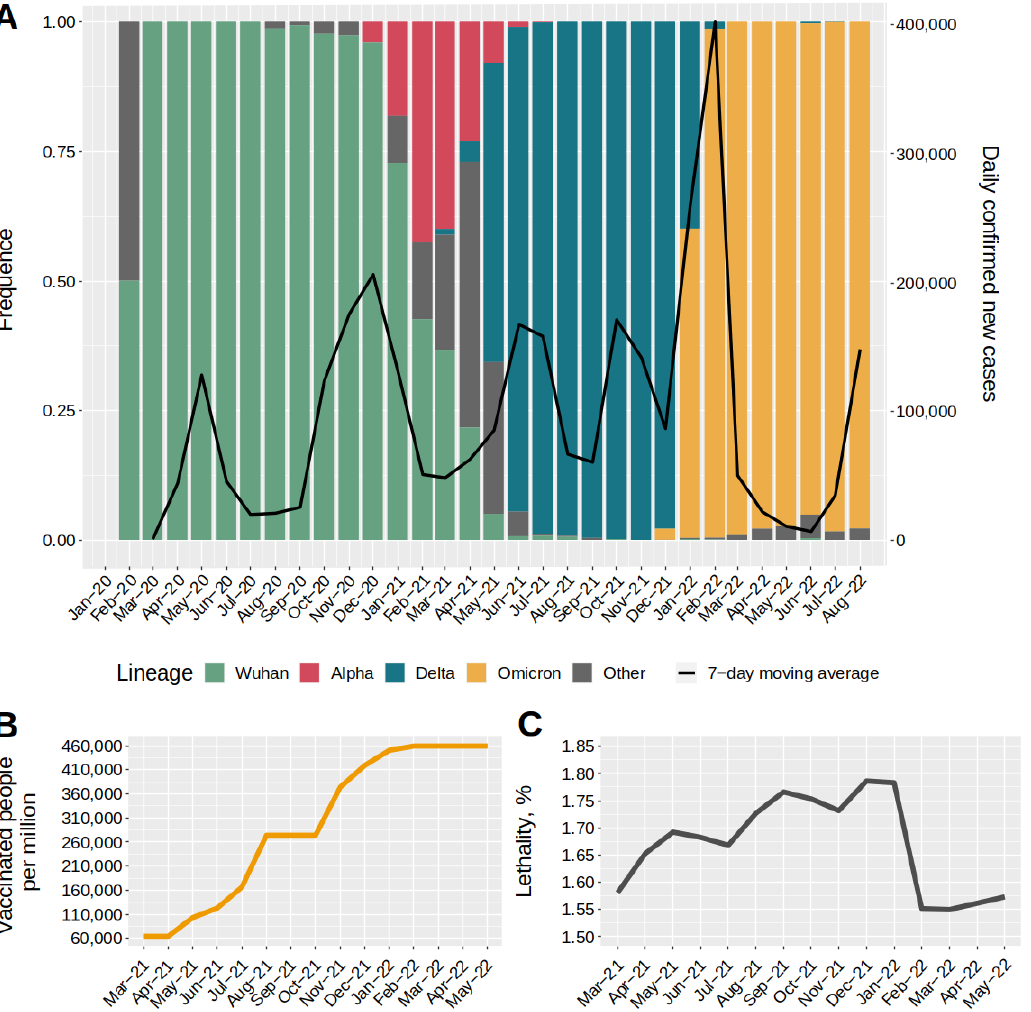
Figure 2. Dynamics of major SARS-CoV-2 genetic lineages in Moscow, COVID-19 incidence, and number of vaccinated individuals. ( A ) Profile of changes in major genetic lineages since viral outbreak in Moscow. The second ordinate scale shows the number of new cases. The black line shows the dynamics of new cases. ( B ) Cumulative value of fully vaccinated patients during mass vaccination in 2021–2022. The ordinate axis shows the number of fully vaccinated people per 1 million inhabitants. ( C ) Value of lethality in 2021–2022. Lethality is expressed as a percentage and was calculated as the ratio of patients who died to those who became ill.